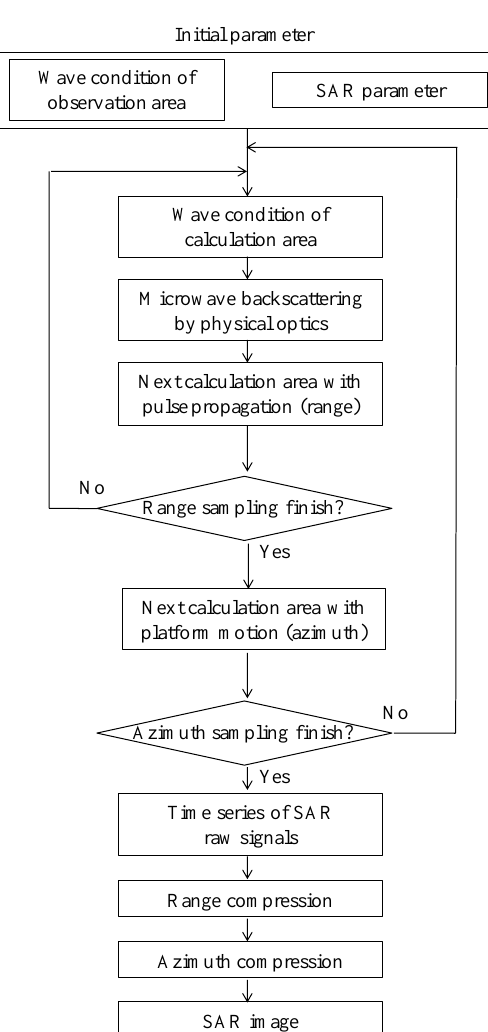
Figure 2. Flowchart of the